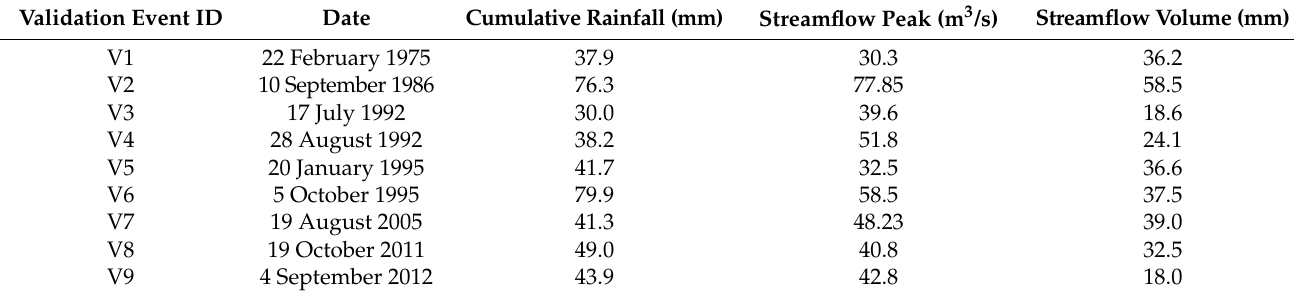
Table 2. List of the storm events selected for validation of the hydrologic